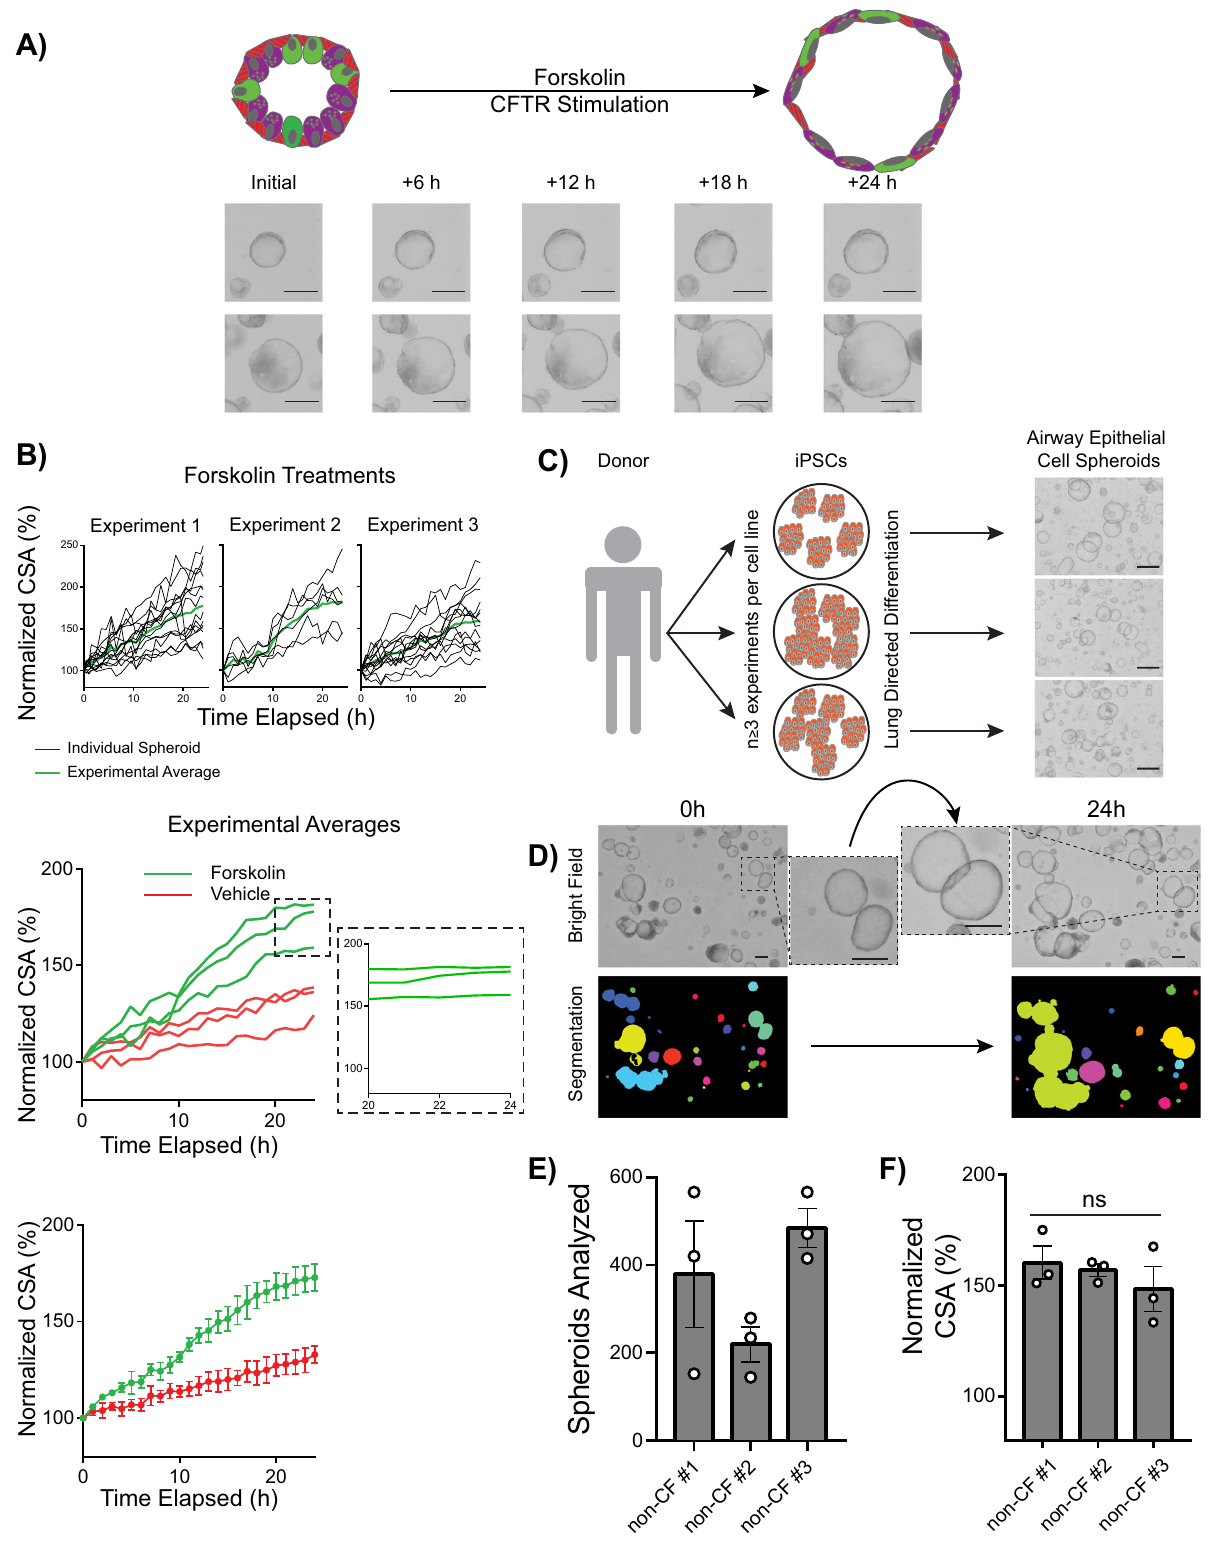
Individual Spheroid Experimental